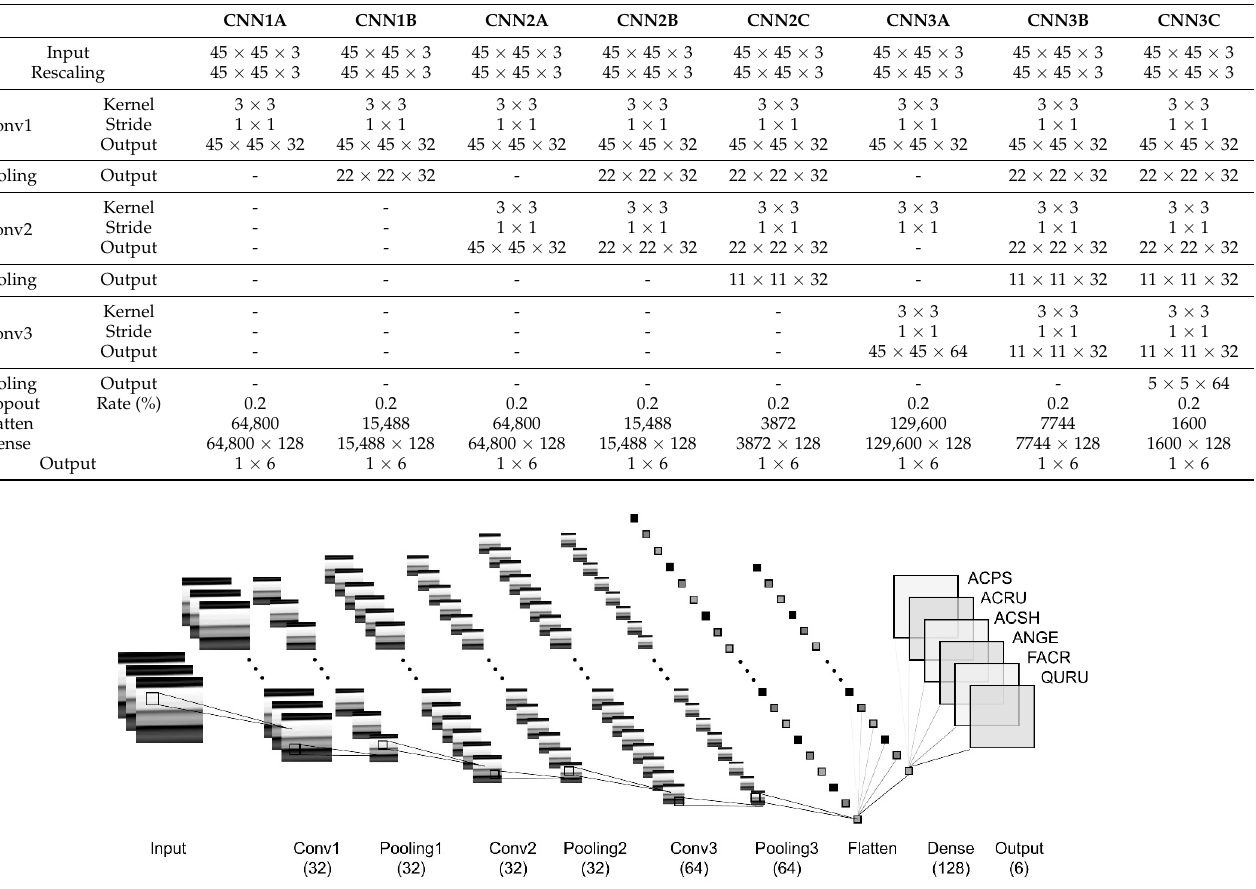
Figure 4. CNN3C architecture: three convolutional layers (Conv1, Conv2, Conv3), pooling layer, flatten layer, fully connected dense layer, output layer, with six dense channels corresponding to the six species.